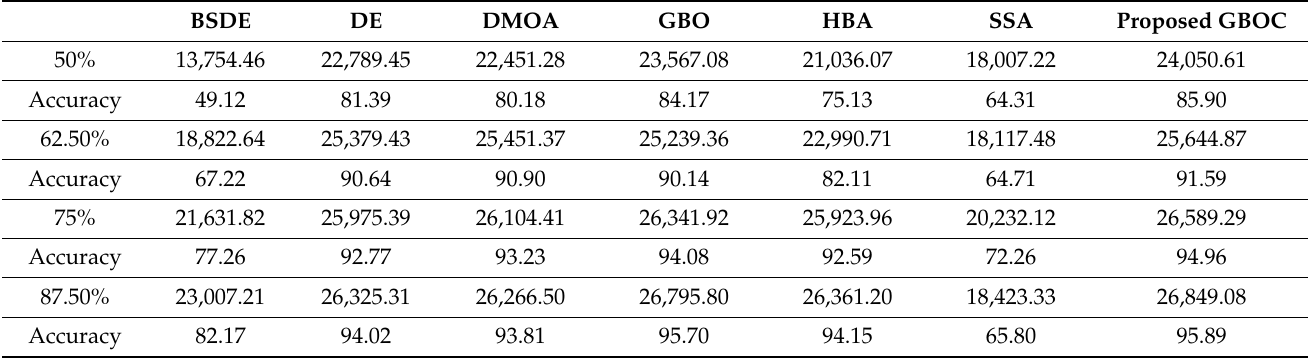
Table 7. Obtained objectives and related accuracies of all of the applied techniques with improved compensation levels.